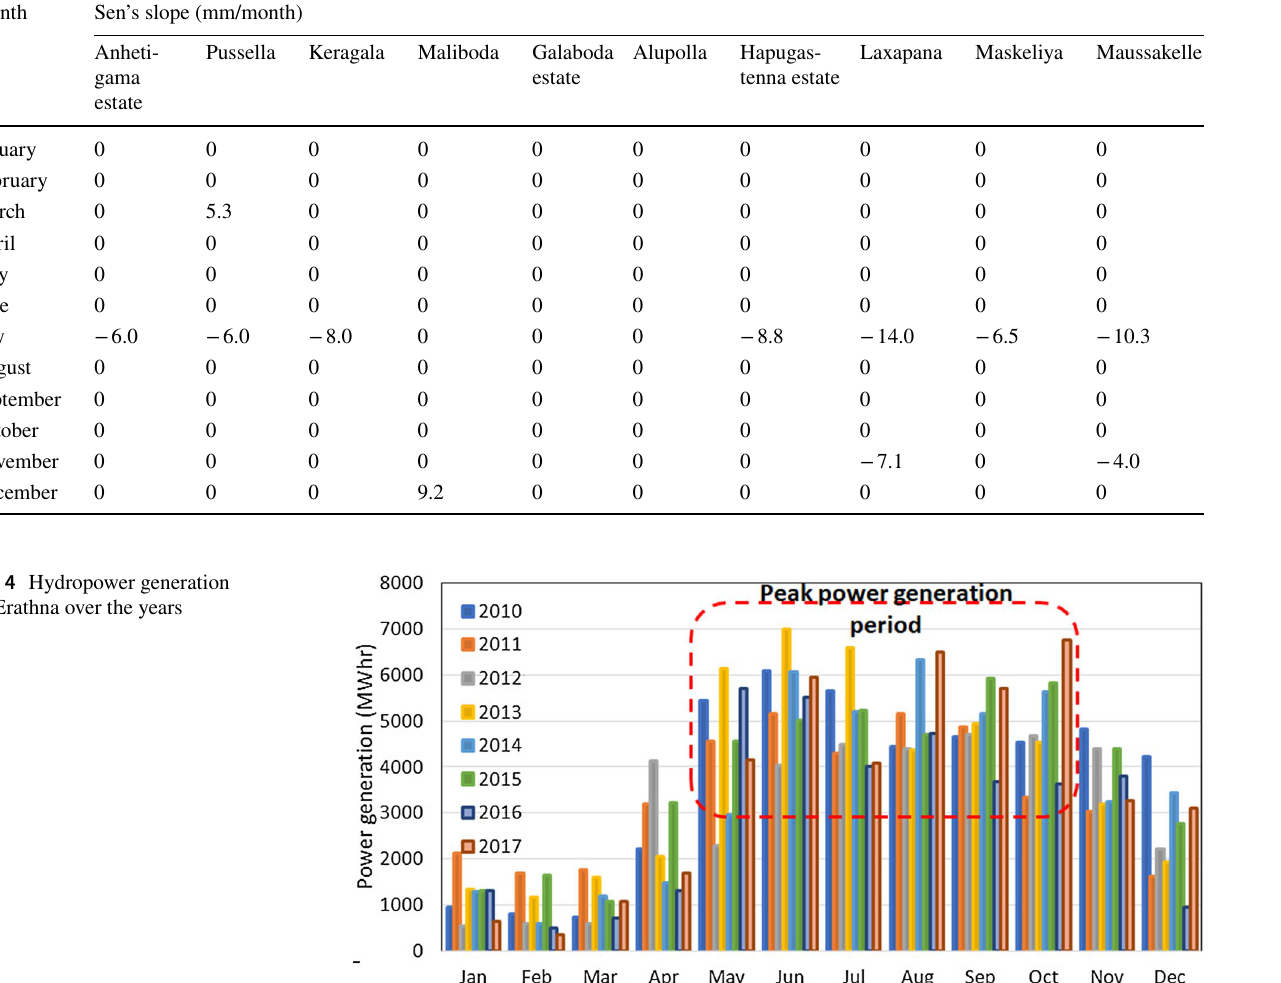
Table 3 Sen’s slope estimator test results for monthly rainfall